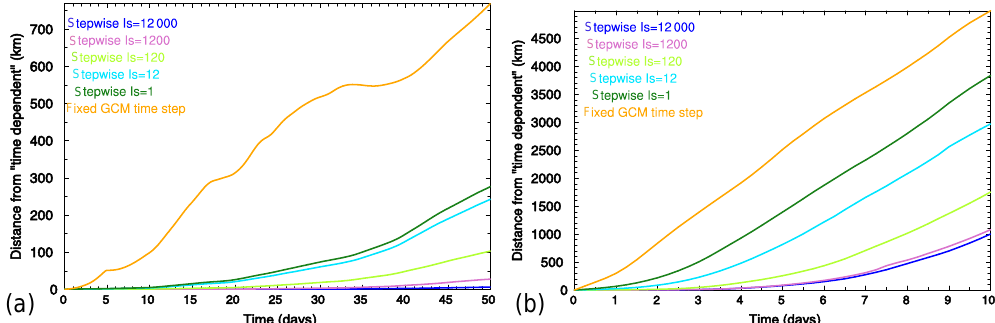
Figure 8. Average distance between the "time-dependent" trajectories and the "stepwise-stationary" ones for the different time-steps with I S = 1 , 12 , 120 , 1200 and 12000 as well as "fixed GCM time steps". The left panel represents the ocean Agulhas trajectories and the right panel the atmospheric ERA-Interim ones. Note that the more intermediate steps used by the "stepwise-stationary" scheme the closer results to the "time-dependent" scheme.